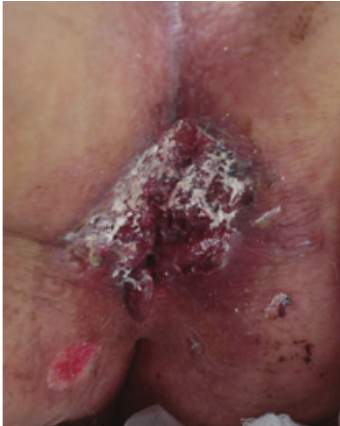
Figure 2: Perineum after electrocautery and cryotherapy.